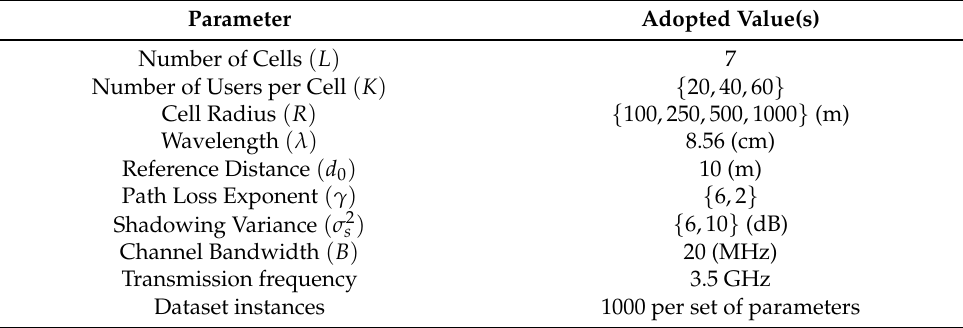
Table 2. System parameters used in the computational